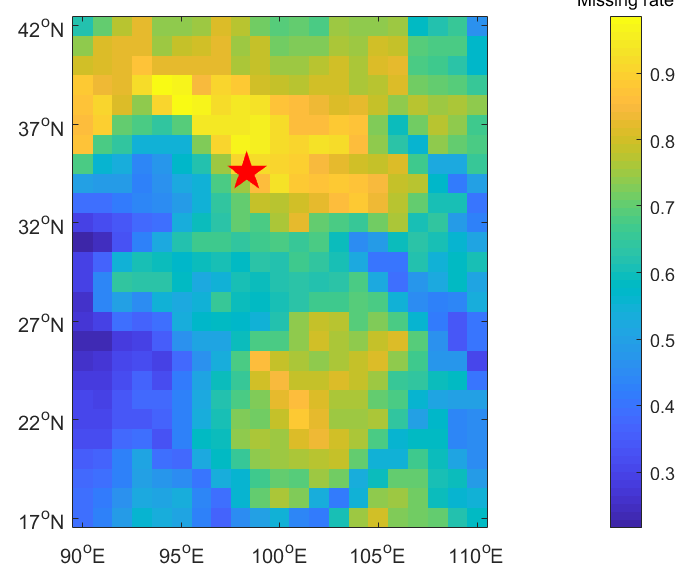
Figure 4. The percentage of invalid data.